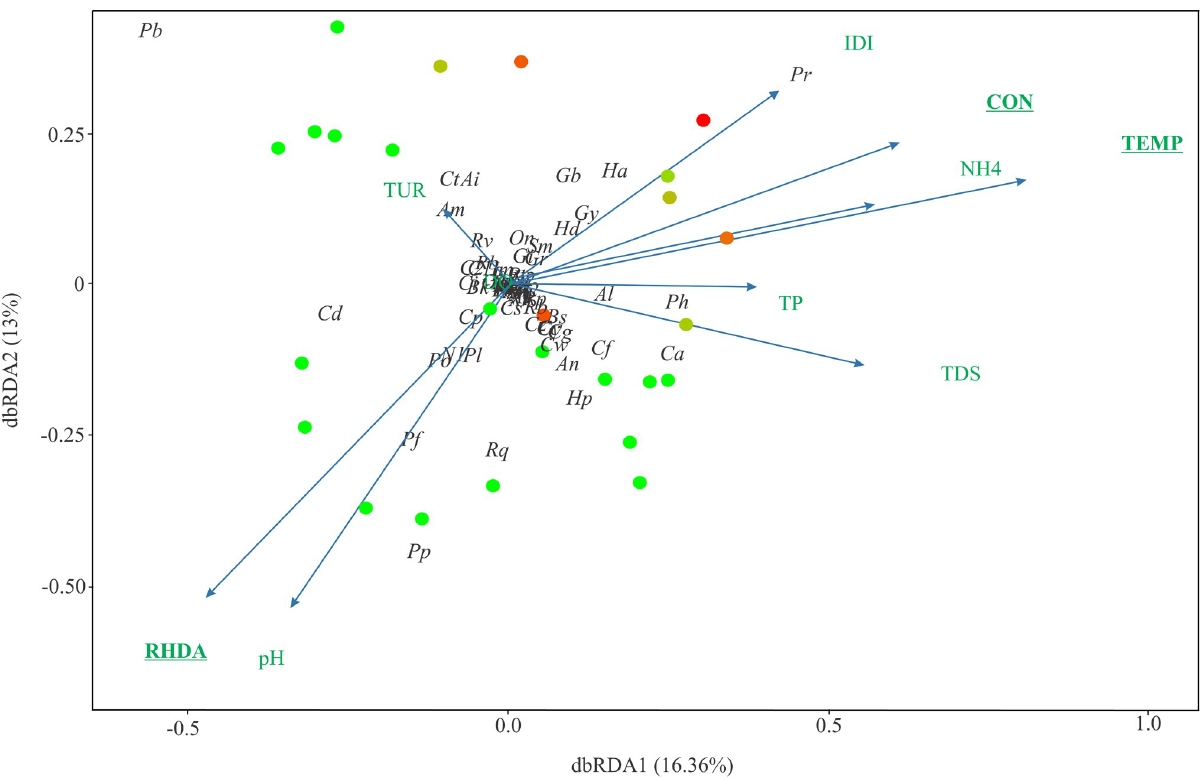
Fig 3. Distanced-based redundancy analyses (dbRDA) plots of species composition and the environmental variables for all streams. The colors demonstrate the degree of urbanization (red), that is, when the point is red, it presents a high degree of urbanization. The arrows indicate how the variables are related to the dbRDA axes and the underlined variables were statistically significant. IDI- Integrated Disturbance Index, RHDA- Rapid Habitat Diversity Assessment, TDS- Total dissolved solids, TP- Total phosphorus, NH4- Ammonia, TPT- Temperature, CON- Conductivity, DO- Dissolved oxygen, TUR- turbidity. Am = Ancistrus mullerae ; An = Ancistrus sp.; Al = Astyanax lacustris , Cd = Cambeva davisi ; Cf = Cambeva aff. davisi ; Ct = Cambeva stawiarski ; Ca = Corydoras aeneus ; Geophagus brasiliensis ; Gy = Gymnotus sylvius Hp = Hisonotus pachysarkos ; Ha = Hypostomus ancistroides ; Hd = Hypostomus derbyi ; N1 = Neoplecostomus sp. 1; Pb = Psalidodon bifasciatus ; Po = Psalidodon bockmanni ; Pf = Psalidodon aff. fasciatus ; Pp = Psalidodon aff. paranae ; Ph = Phalloceros harpagos ; Pr = Poecilia reticulata . See S2 Table for the code for the other species.